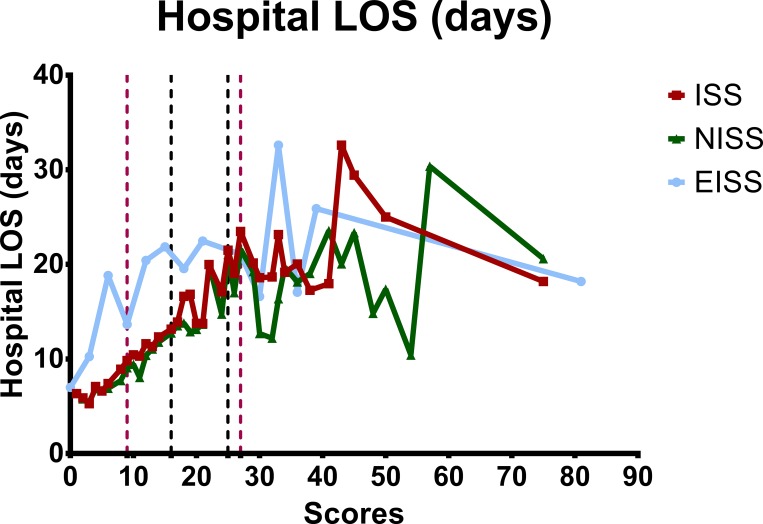
The hospital LOS-to-severity score relationships of all patients classified according to the ISS, NISS, and EISS.